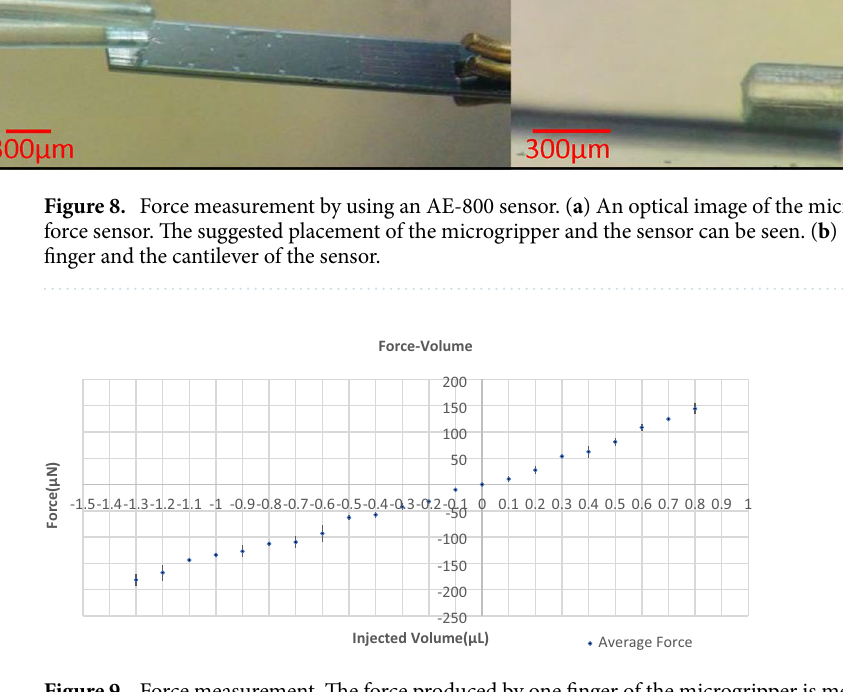
Figure 9. Force measurement. The force produced by one finger of the microgripper is measured under an optical microscope by using an AE-800 piezoresistive force sensor. The produced force changes are shown versus the changes in the injected volume of water in the cavity. The negative forces are representing the produced forces during the closing